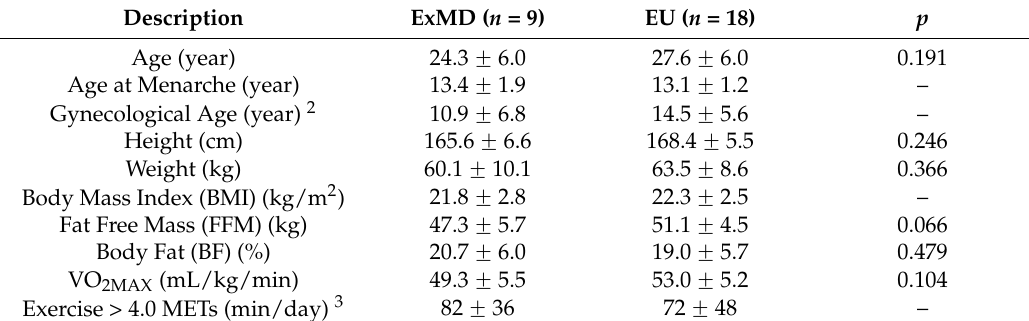
Table 1. Demographic Characteristics of Exercise-Associated Menstrual Dysfunction (ExMD) and Eumenorrheic (EU) Groups 1